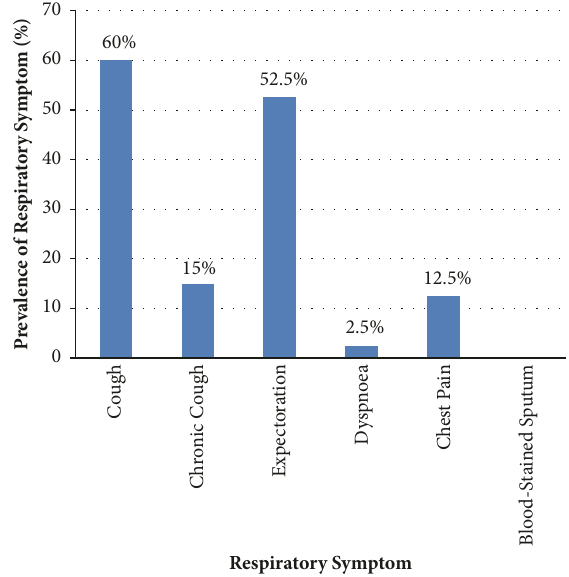
Figure 1: Self-reported prevalence of respiratory symptoms among participants. Chronic cough refers to any persistent cough lasting more than four